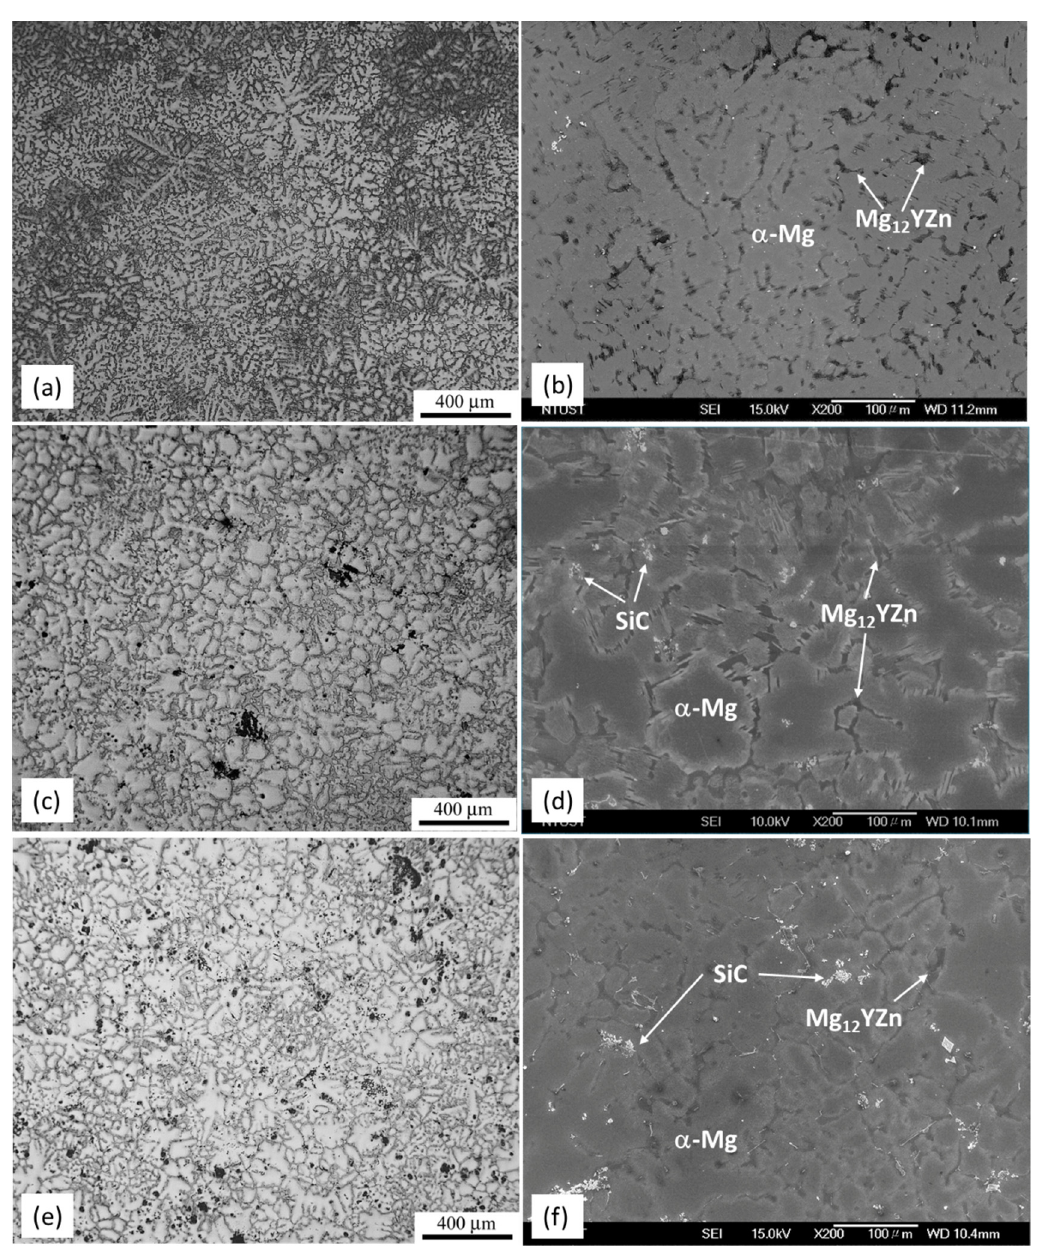
Figure 1. Optical micrographs of WZ73 and metal matrix composites (MMCs): ( a ) WZ73; ( c ) WZ73-1.5 vol% SiC and ( e ) WZ73-2.5 vol% SiC; SEM micrographs of WZ73 and MMCs: ( b ) WZ73; ( d ) WZ73-1.5 vol% SiC and ( f ) WZ73-2.5 vol% SiC.